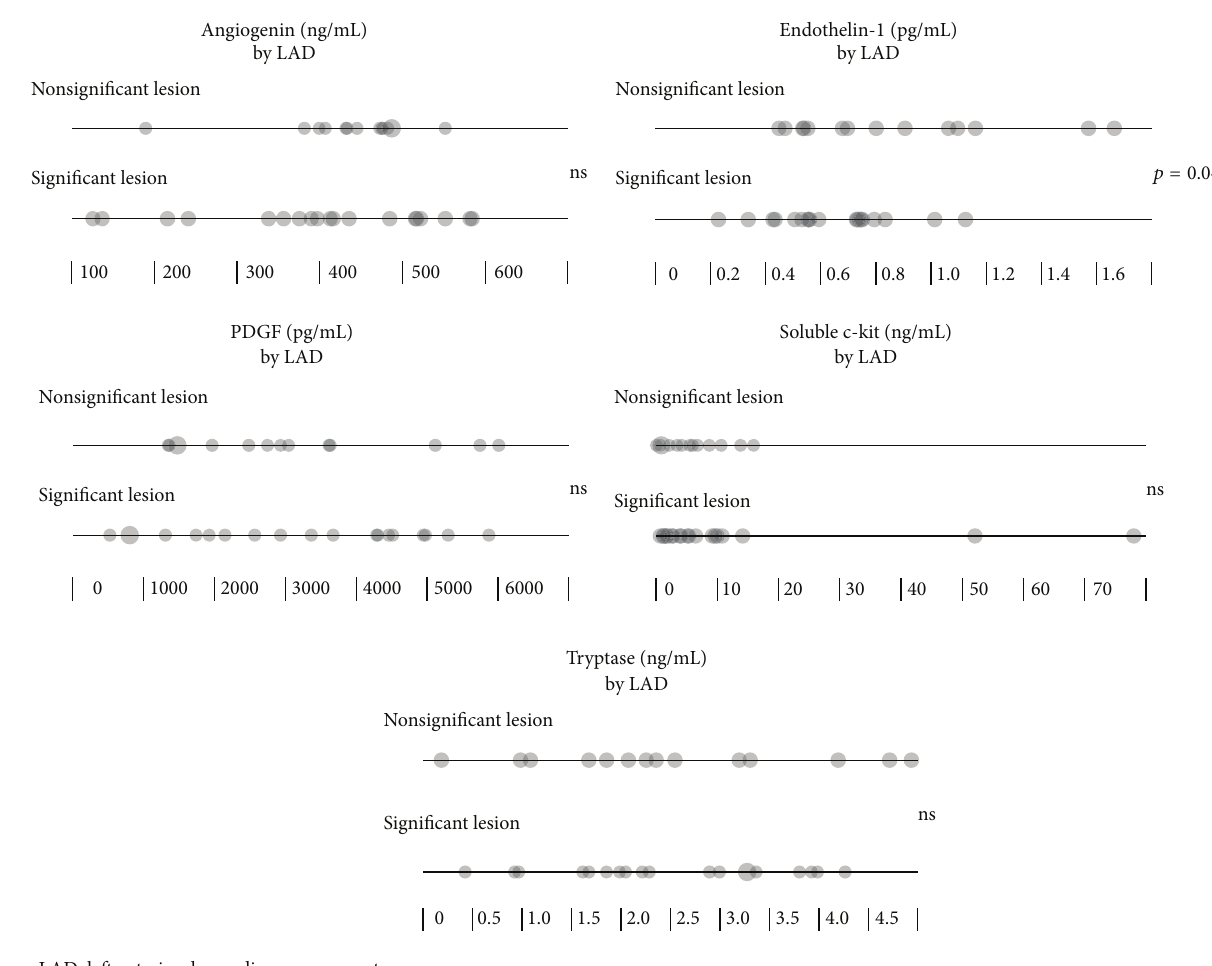
Figure 3: The differences in tryptase, PDGF, soluble c-kit, ET-1, and angiogenin levels between STEMI patients with or without significant LAD